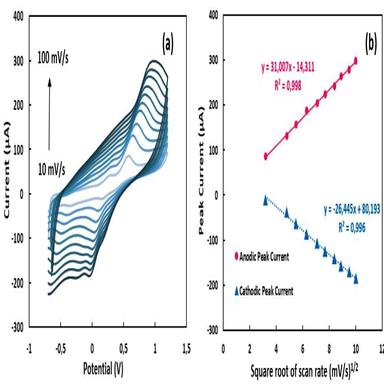
CVs of (a) Nafion/MWCNTs/Pt NPs/TiN electrode in PBS (50 mM, pH = 7.4) containing dopamine (100 µM) at different scan rates (10, 20, 30, 40, 50, 70, 80 and 100 mV/s), (b) dependence of anodic currents vs. square root of scan rate.